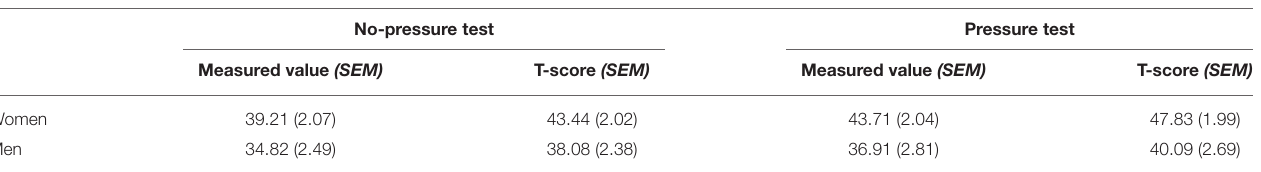
TABLE 2 | Mean scores of state anxiety before each